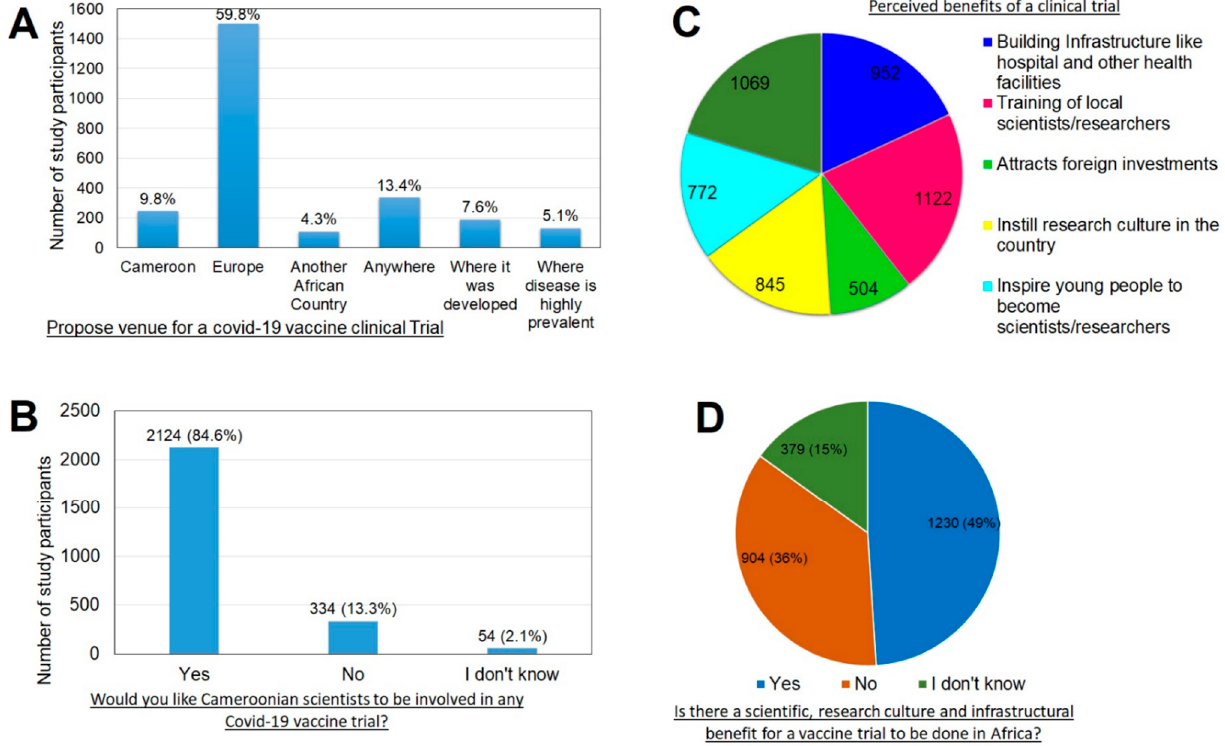
Figure 3. Cameroonian perception of a COVID-19 vaccine clinical trial. ( A ) proposed venues of a COVID-19 vaccine clinical trial. ( B ) opinions with respect to involvement of Cameroonian scientists in a COVID-19 vaccine clinical trial. ( C ) shows what Cameroonians think will be benefits of a well conducted clinical trial. ( D ) shows the percentage of the study participants who believe there are benefits/or not of a well-done clinical trial.